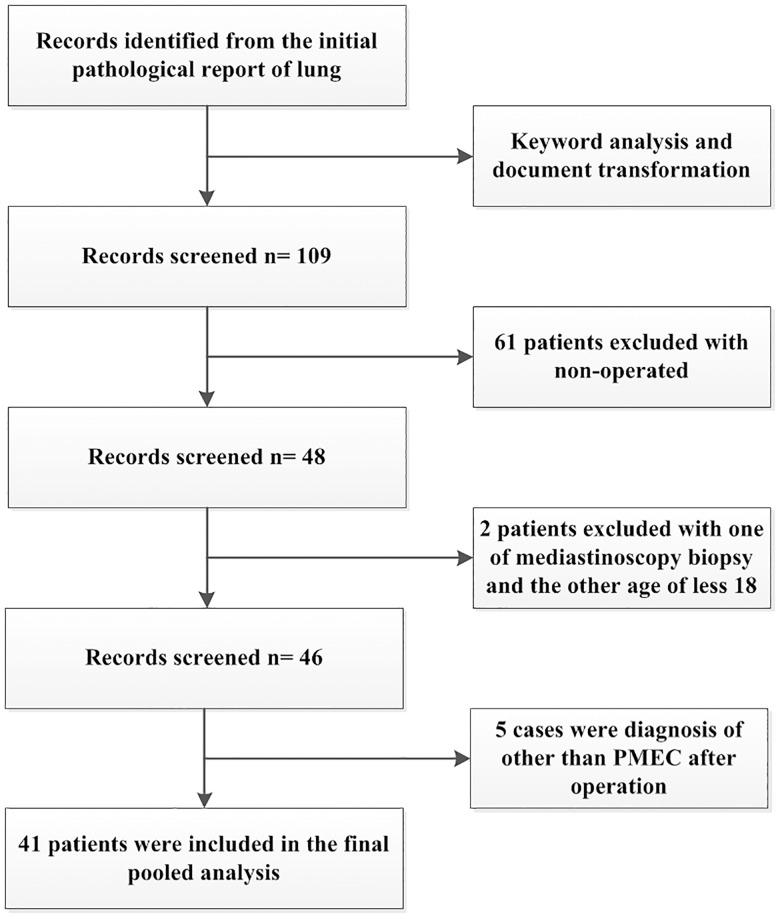
Patient flow diagram.